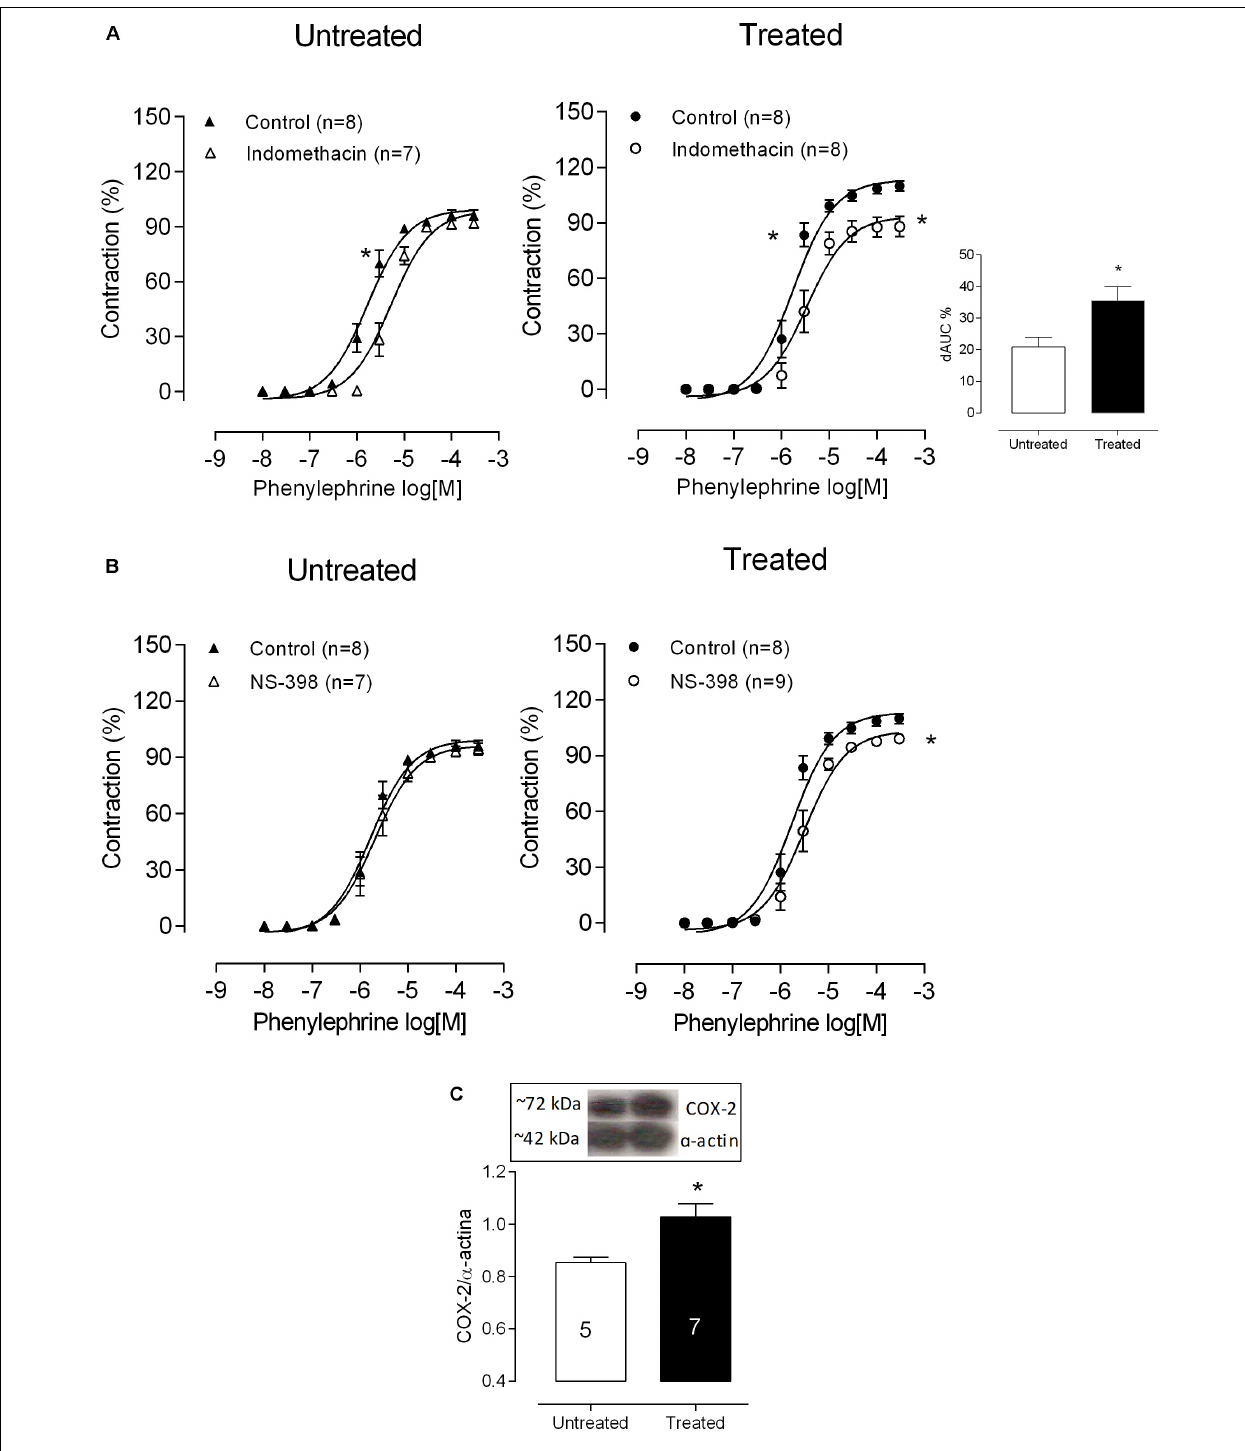
FIGURE 4 | Role of COX-2-derived prostanoids in altered phenylephrine responses after lead treatment. The effects of (A) the non-selective COX inhibitor indomethacin and (B) the selective COX-2 inhibitor NS398 on the concentration-response curve to phenylephrine in mesenteric rings from untreated and treated rats. The insert shows differences in the area under the concentration-response curves (dAUC) in the presence and absence of indomethacin. * P < 0.05 versus control using two-way ANOVA and Bonferroni post hoc test or Student’s t -test. (C) Densitometric analysis of Western Blots for COX-2 protein expression in mesenteric arteries from untreated and treated rats. Representative blots are also shown. * P < 0.05 versus untreated by Student’s t -test. Data are expressed as the mean ± SEM. n denotes the number of animals used.